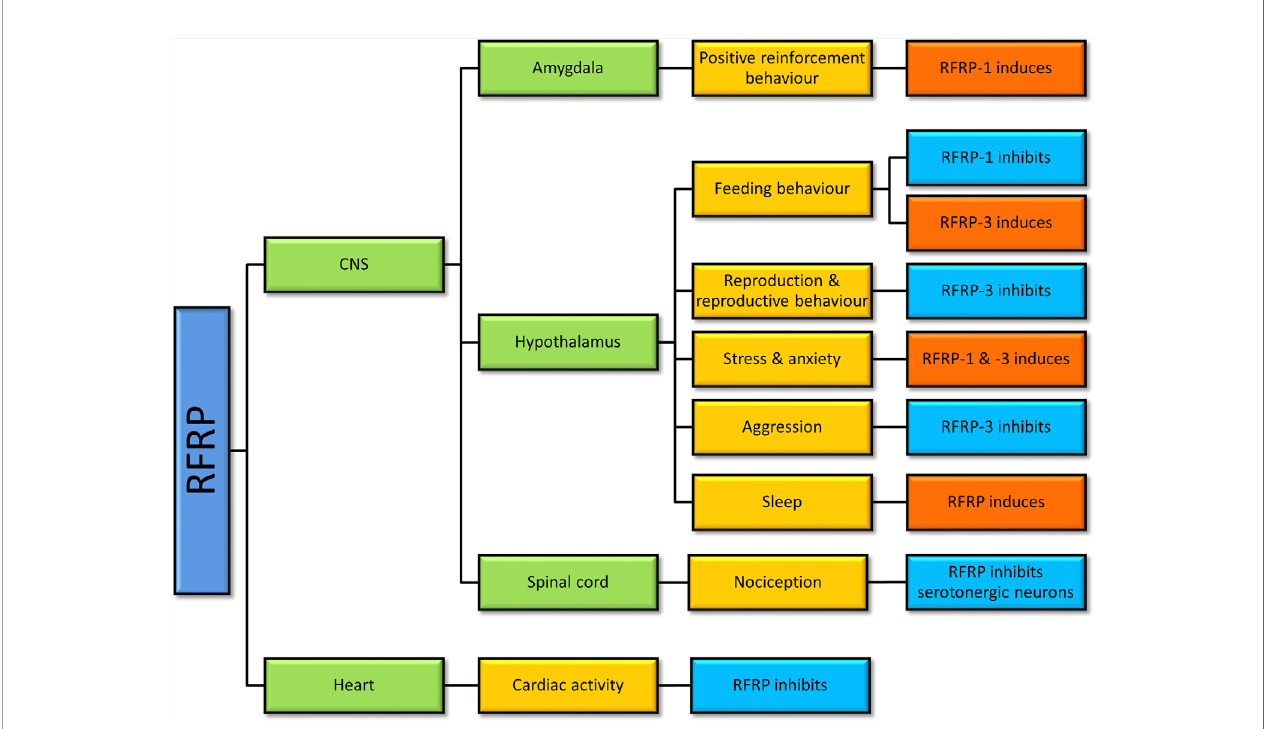
FIGURE 2 | Physiological actions of gonadotropin-inhibitory hormone (GnIH)/RFamide-related protein (RFRP) in vertebrates. Studies of RFRP in vertebrates have determined that RFRP is involved in various physiological actions centering mainly around the hypothalamus, but not limited to that